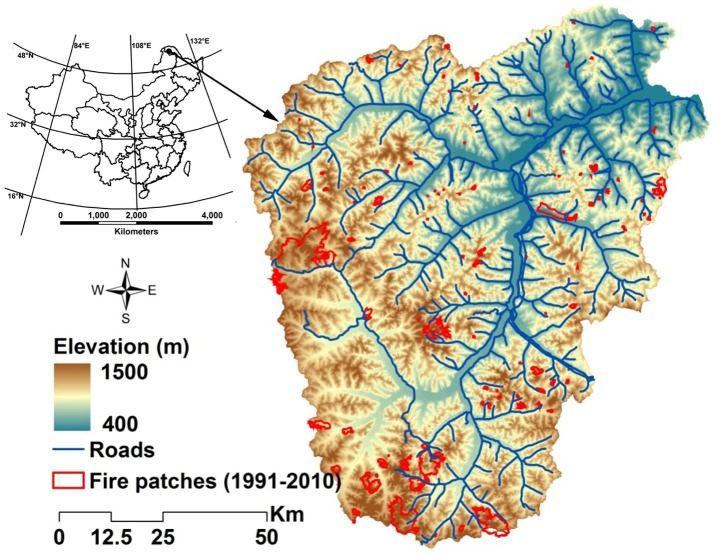
Study area with delineated fire patches from 1991 to 2010, roadway coverage, and digital elevation model.